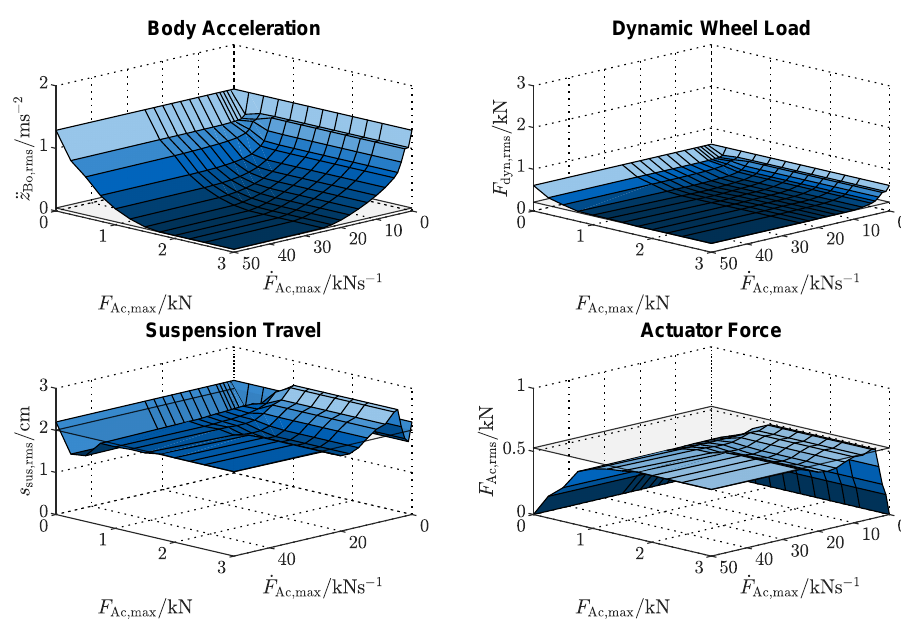
Figure 8. RMS surface plots for the 36kmh − 1 single-obstacle